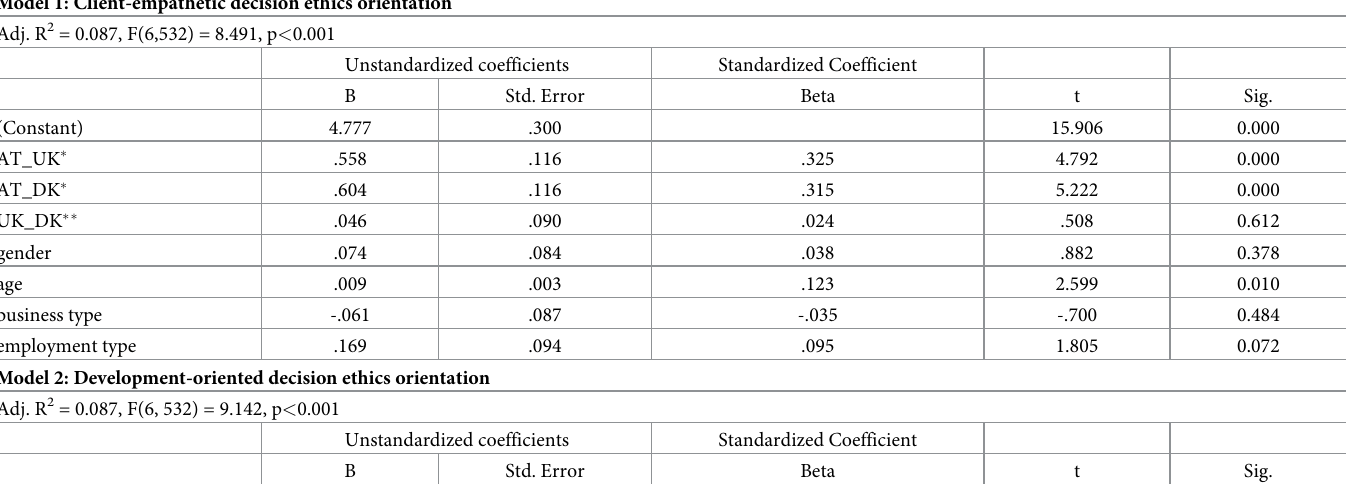
Model 2: Development-oriented decision ethics orientation